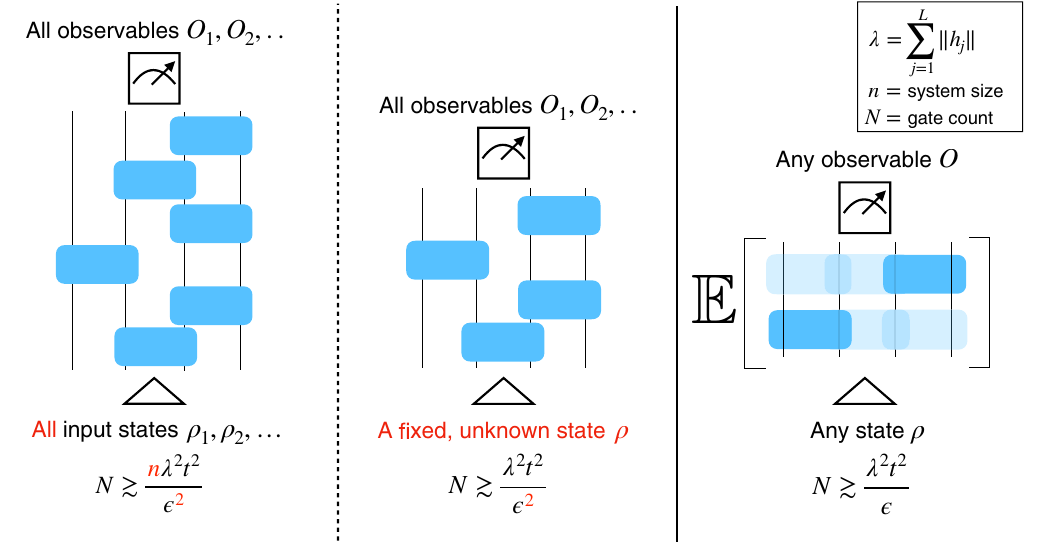
FIG. 1. Pictorial summary of the main results. (Left) To sample a product formula that works for all n -qubit input states and observ- ables with high probability , the number of gates is larger than sampling a product formula that works for a fixed, yet arbitrary, input state (center). Resampling fresh product formulas every time (right) produces an average channel that requires even fewer gates; this is the original Q DRIFT guarantee